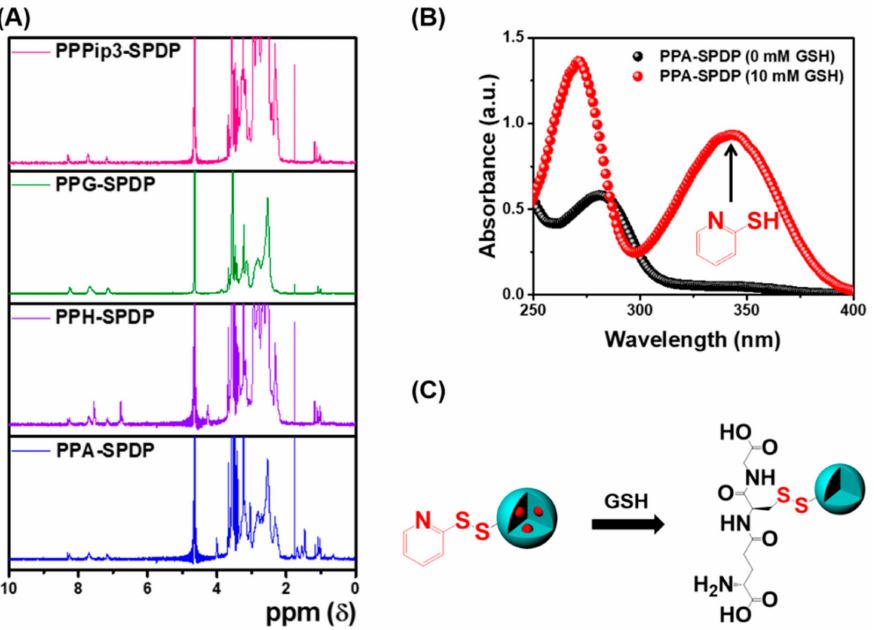
Figure 4. ( A ) 1 H NMR spectra of PPA-SPDP variants. ( B ) Exposure of PPA-SPDP conjugate with and without GSH and the changes were examined using UV-Vis spectroscopy. ( C ) Schematic illustration of GSH-treated PPA-SPDP conjugate.